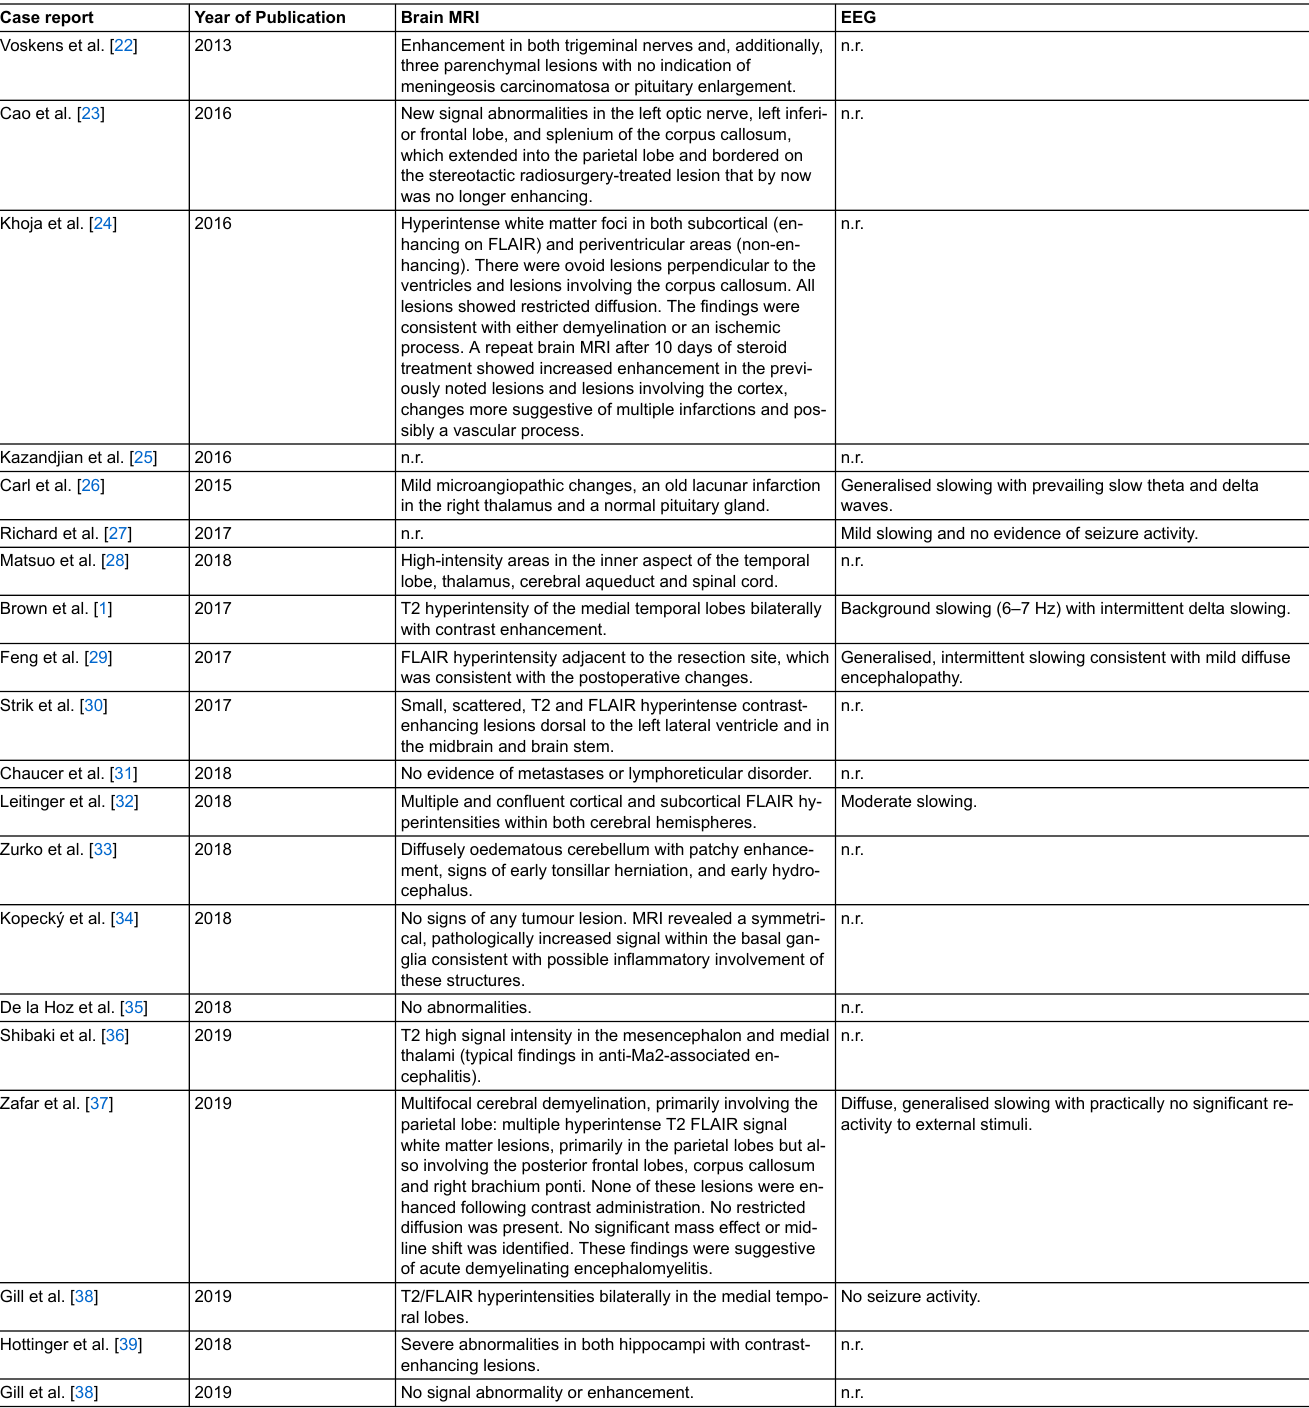
of acute demyelinating encephalomyelitis.